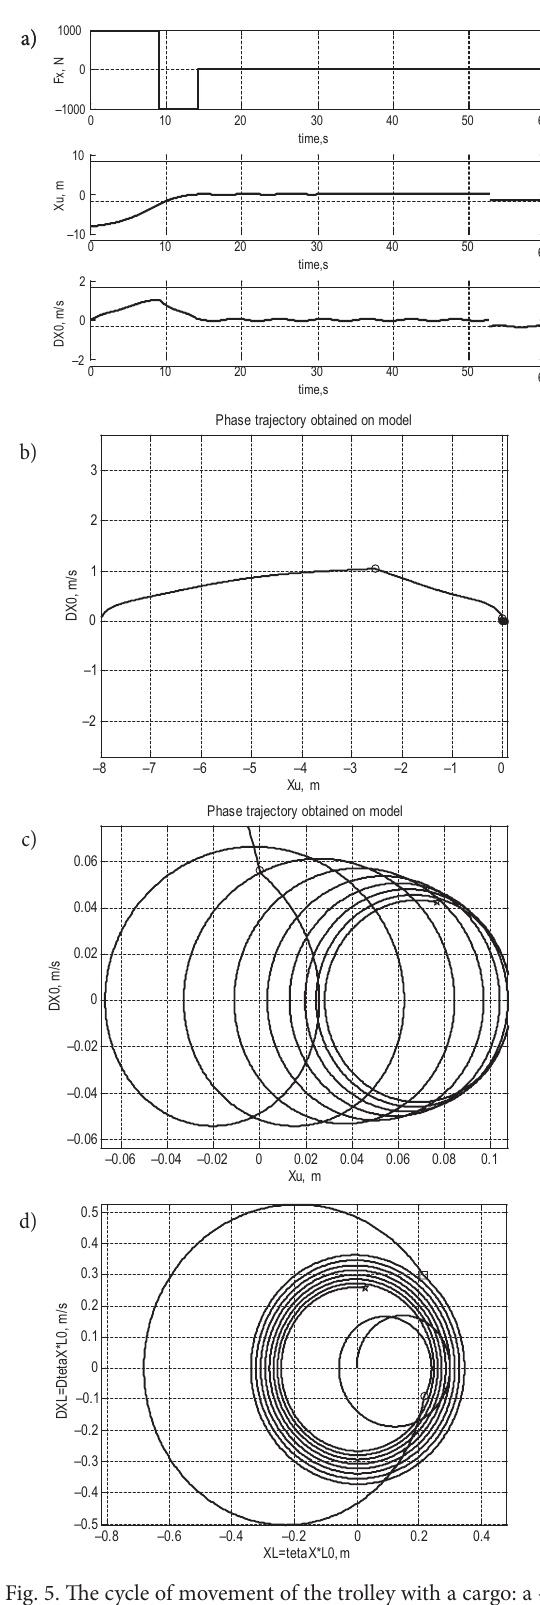
Fig. 5. The cycle of movement of the trolley with a cargo: a – a change of the force generated by the engine, dislocation and velocity; b – the phase trajectory of the trolley; с – the end of the phase trajectory; d – the phase trajectory of the cargo in respect of the attachment point (a circle means the start of reversing; a square – the moment of switching-off the engine; the asterisk – the end of the phase trajectory)